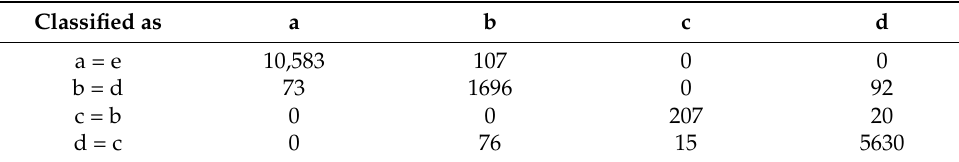
Table A4. The confusion matrix for trim set as outlet variable.